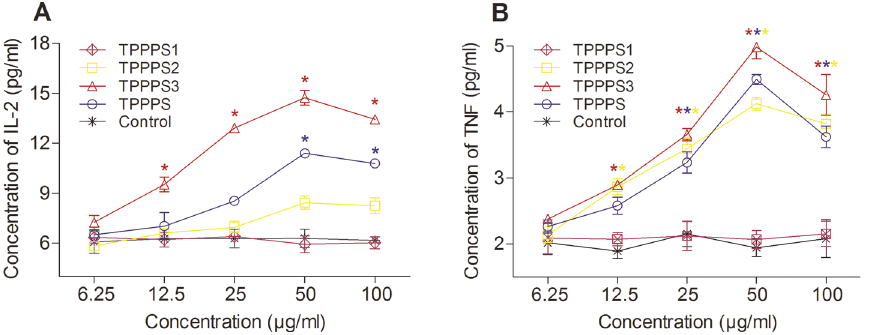
Fig 4. Effects of TPPPS1-3 and TPPPS on IL-2 and TNF secretion in vitro . Activated splenocytes in 96- well plates were treated with different concentrations of TPPPS1-3 and TPPPP, then IL-2 and TNF in the supernatant was detected by ELISA. PBS treatment wells served as the control, and the values are presented as mean ± SD of five independent experiments. An asterisk indicates that the value of the corresponding group was significantly different from that of the control group ( P < 0.05, ANOVA).